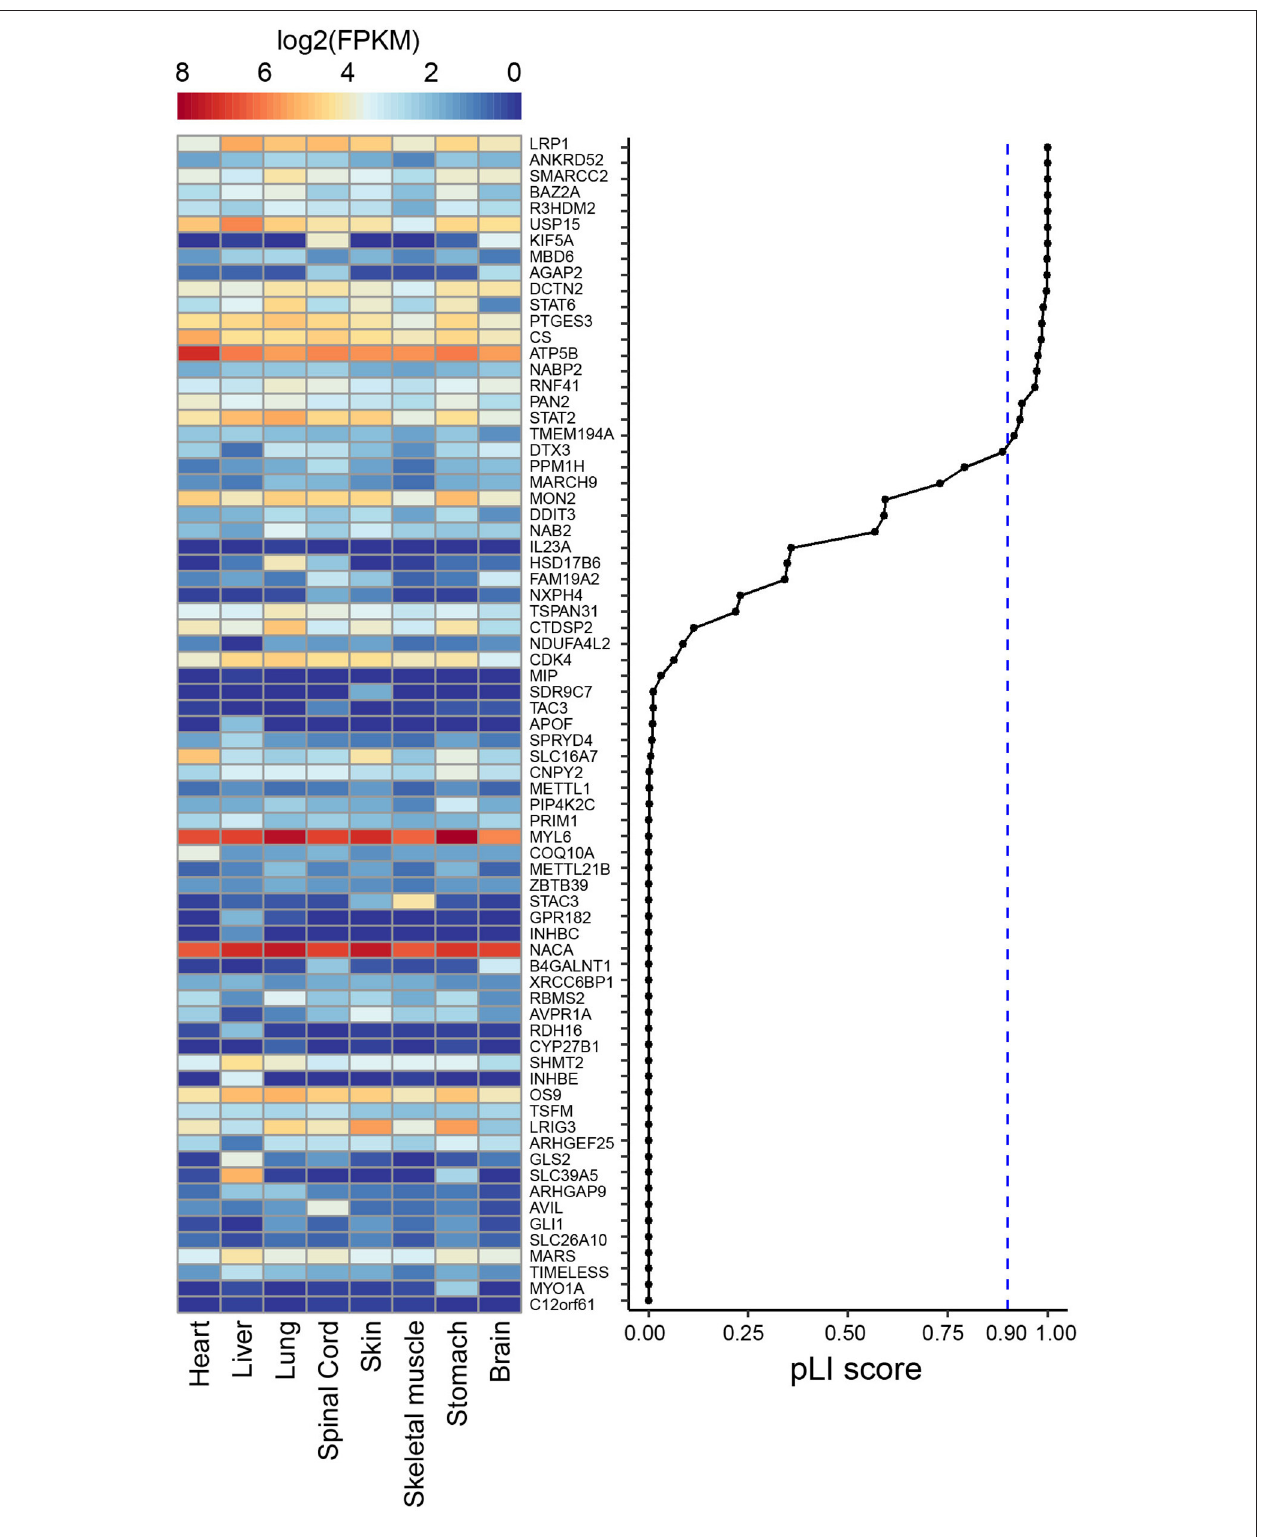
FIGURE 4 | Heat map showing publically available gene expression data (in log 2 FPKM) amongst 8 human fetal tissues from ENCODE for the 73 genes that are included in the deletion found in individual 2. Genes are ranked according to their pLI score from gnomAD (Karczewski et al., 2020).